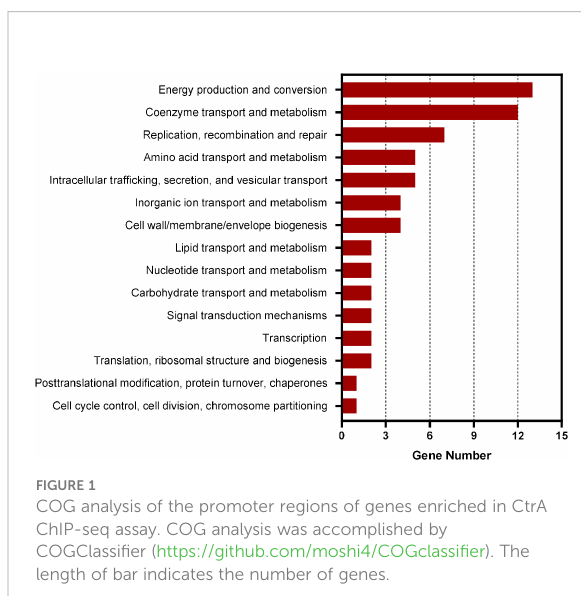
FIGURE 1 COG analysis of the promoter regions of genes enriched in CtrA ChIP-seq assay. COG analysis was accomplished by COGClassi fi er (https://github.com/moshi4/COGclassi fi er). The length of bar indicates the number of